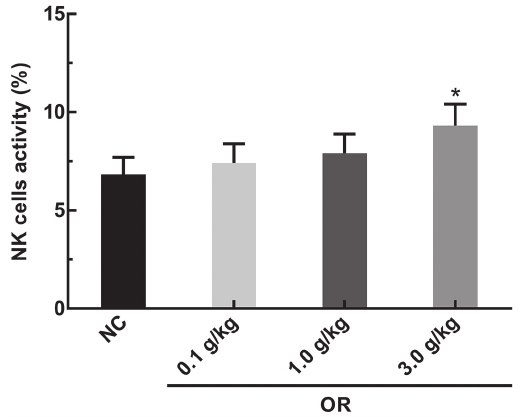
FIGURE 2 - Effects of OR on NK cell activity. Data are means ± SD (n = 10). The symbol (*) indicates significant differences. * P < 0.05 compared with the NC group. NK cells, natural killer cells; OR, Oviductus ranae ; NC, normal